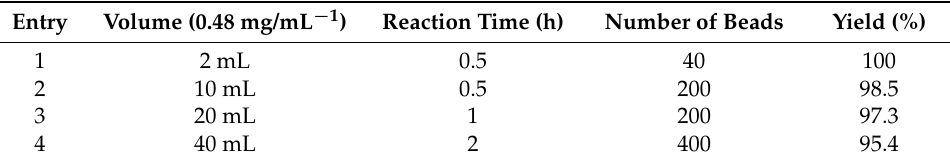
Table 5. Chitosan-immobilized SrtA-mediated P-113